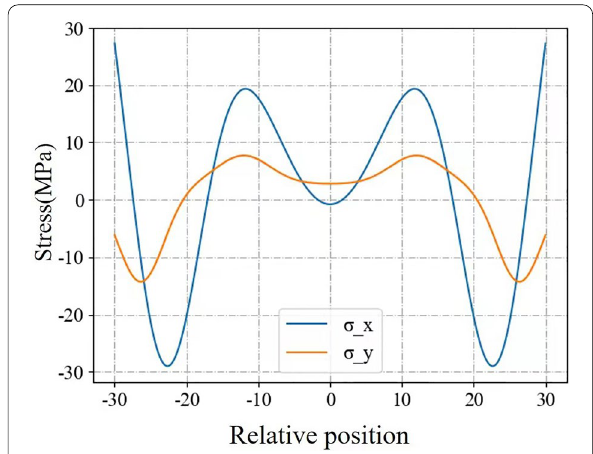
Figure 4 Typical initial residual stress curve within